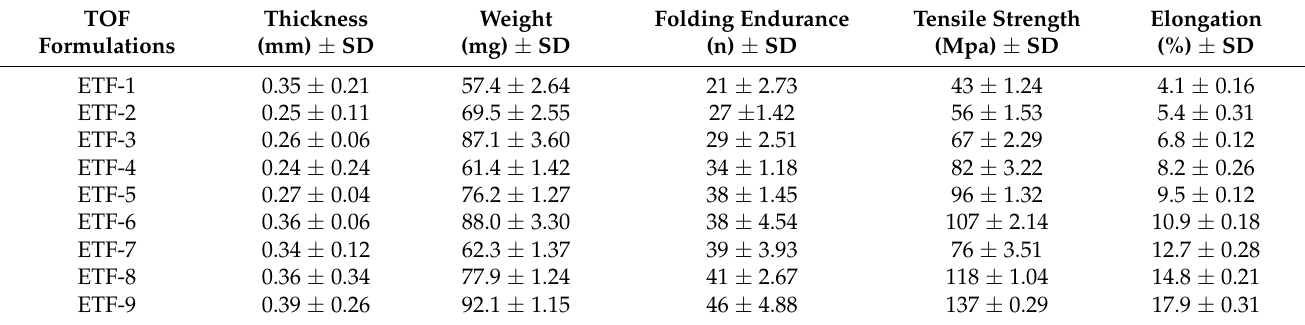
Table 3. Results of TOFs for thickness, weight, folding endurance, tensile strength and % elongation. TOF